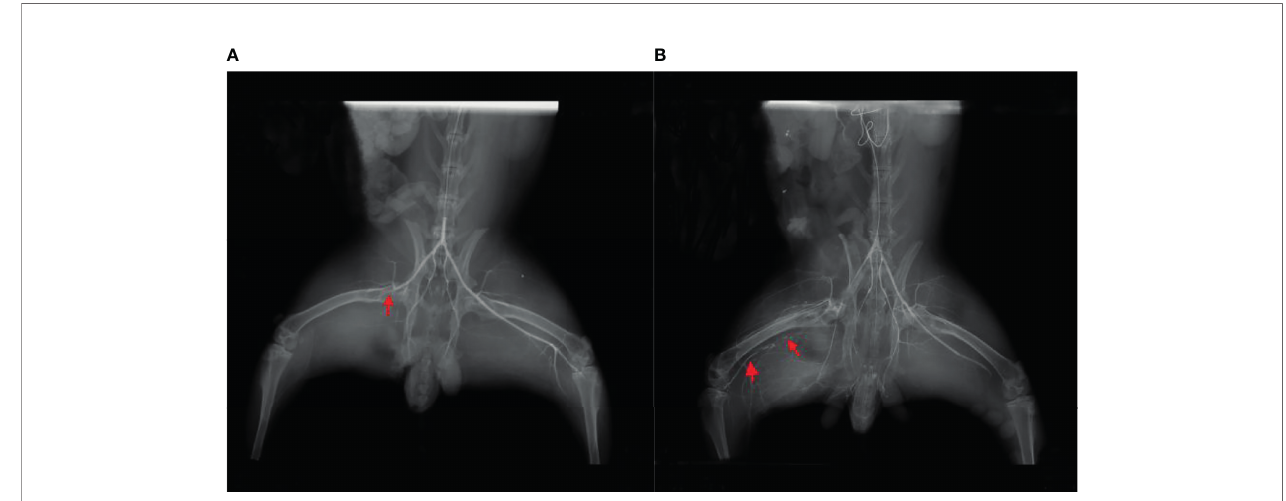
FIGURE 2 | (A) Angiography immediately after ligation of the unilateral femoral artery of the lower extremity in rabbits. The thin arrow indicates ligation without recanalization of the femoral artery. (B) Angiography of unilateral femoral artery ligation in the lower extremity in rabbits at the third week. The thin arrow indicates ligation without recanalization of femoral artery, and the bold arrow shows the formation of collateral